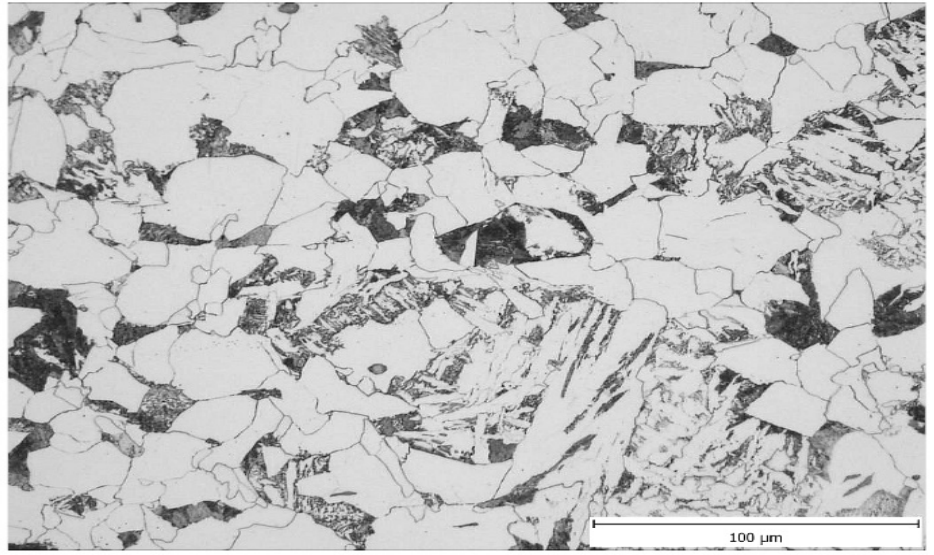
Figure 15. Microstructure consisting of allotriomorphic ferrite, pearlite and acicular ferrite in the centre (sample V1).